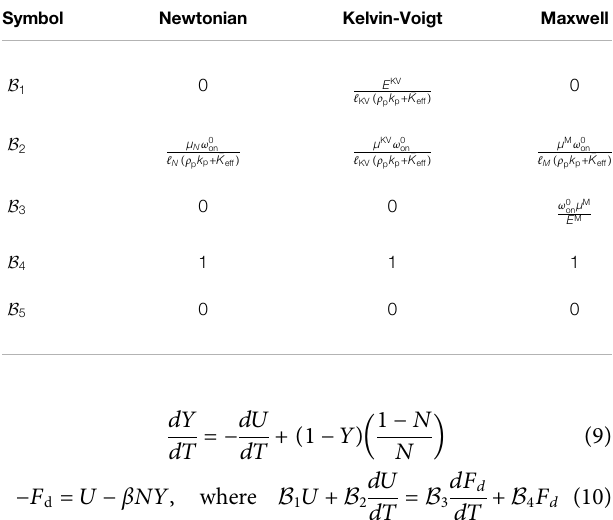
TABLE 2 | Dimensionless parameters quantifying the ambient medium stress on moving fi lament. Here, ℓ A and w A are the length and width of the fi lament aggregate interacting with motors and allow one to go from the stress to a force description. Displacements are scaled with A . We assume a continuum description is valid and that strains in the fl uid/medium network may be appropriately de fi ned using elastic and viscous moduli. We consider three cases: (a) a Newtonian fl uid, (b) Kelvin-Voigt liquid-like viscoelastic medium, and(c) Maxwellsolid-likemedium.Models (b)and(c)serveaslimiting casesof the more general linear Jeffreys ’ model that belongs to the class of anti-Zener models and the standard solid model (SSM) of classical viscoelasticity. The ratio B 2 / B 1 for the Kelvin-Voigt model is a ratio of rheological to motor kinetics time-scales. Parameter B 3 has a similar interpretation for the Maxwell model. The anti-zener Jeffrey element results in a relationship involving the second derivative of the strain/displacement and results in the additional term with coef fi cient B 5 , and is not analyzed in this paper.